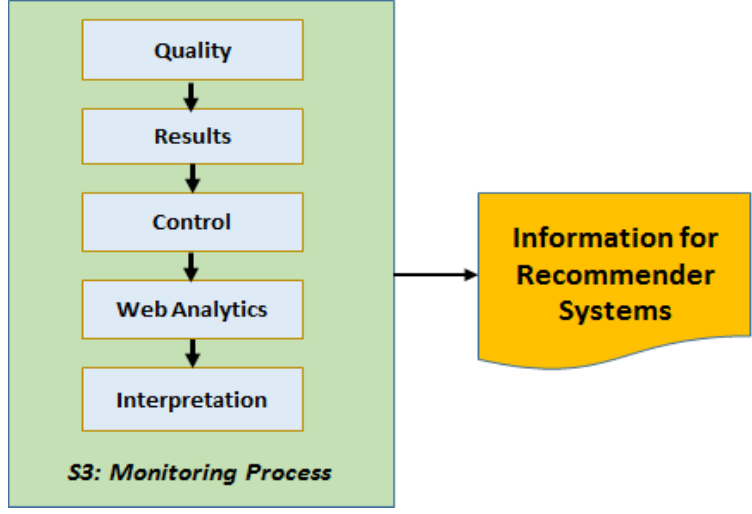
Figure 6. Monitoring process subsystem.